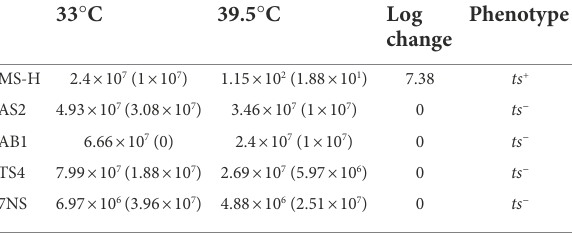
Data are presented as means (standard deviation). Log change denotes the difference between the calculated viable counts measured at 33 ° C and the viable counts measured at